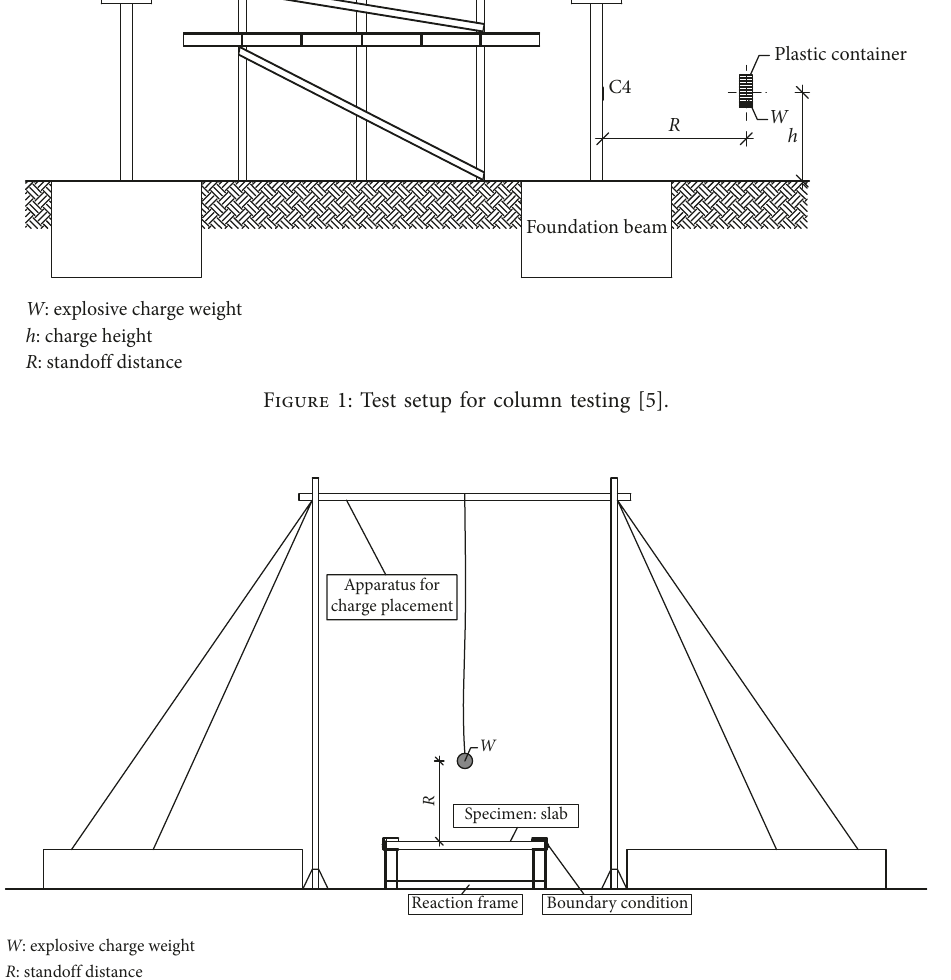
Figure 2: Test setup for RC slab testing